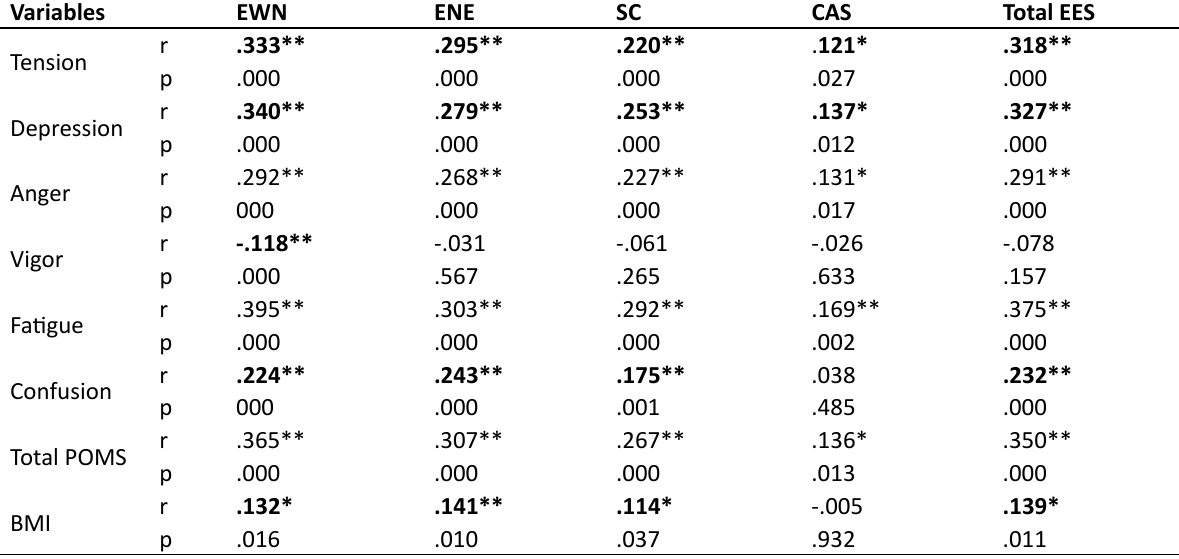
Table 5. The relationship between emotional profile and emotional eating status of the athletes’ social isolation period